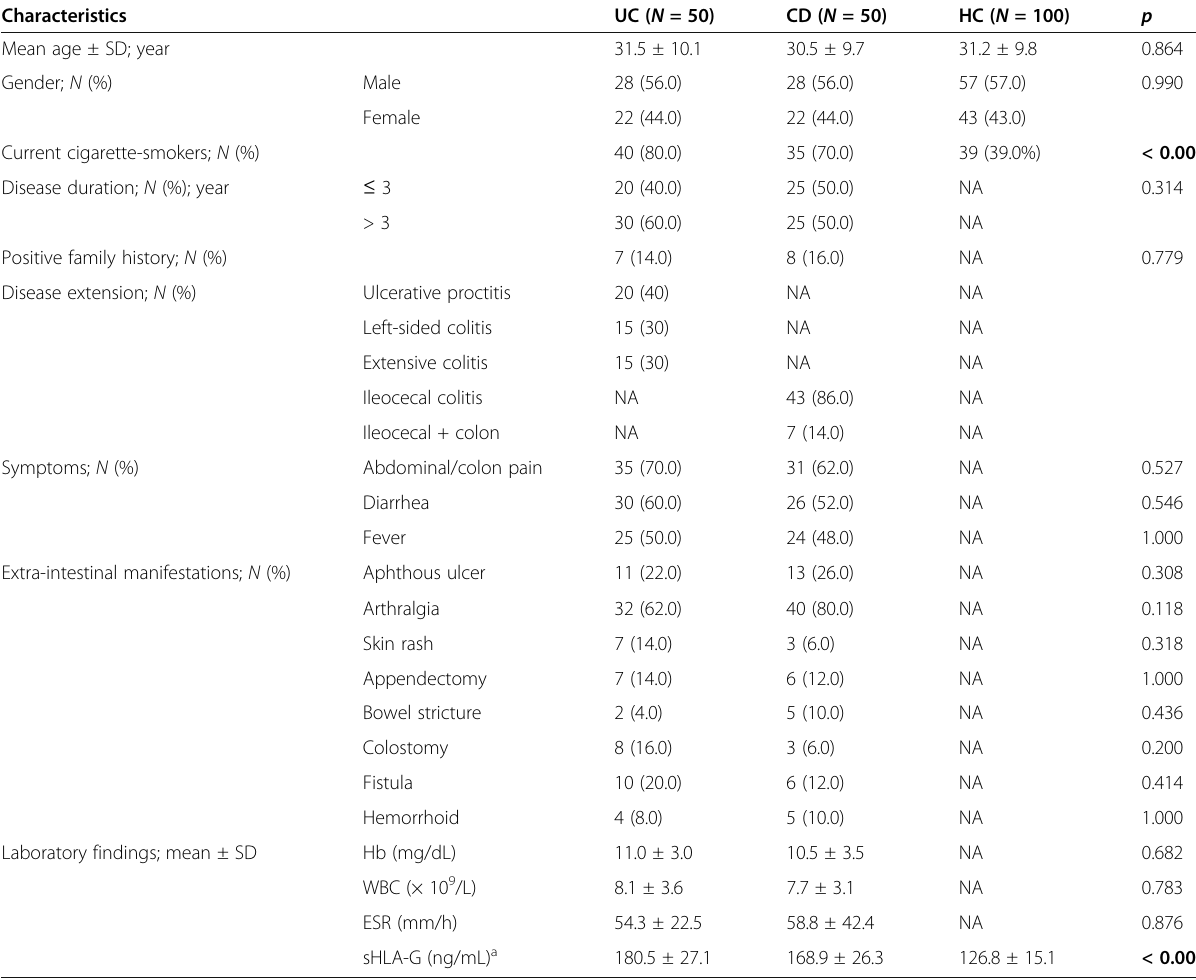
Table 1 Baseline characteristics of inflammatory bowel disease (ulcerative colitis and Crohn ’ s disease) patients and controls